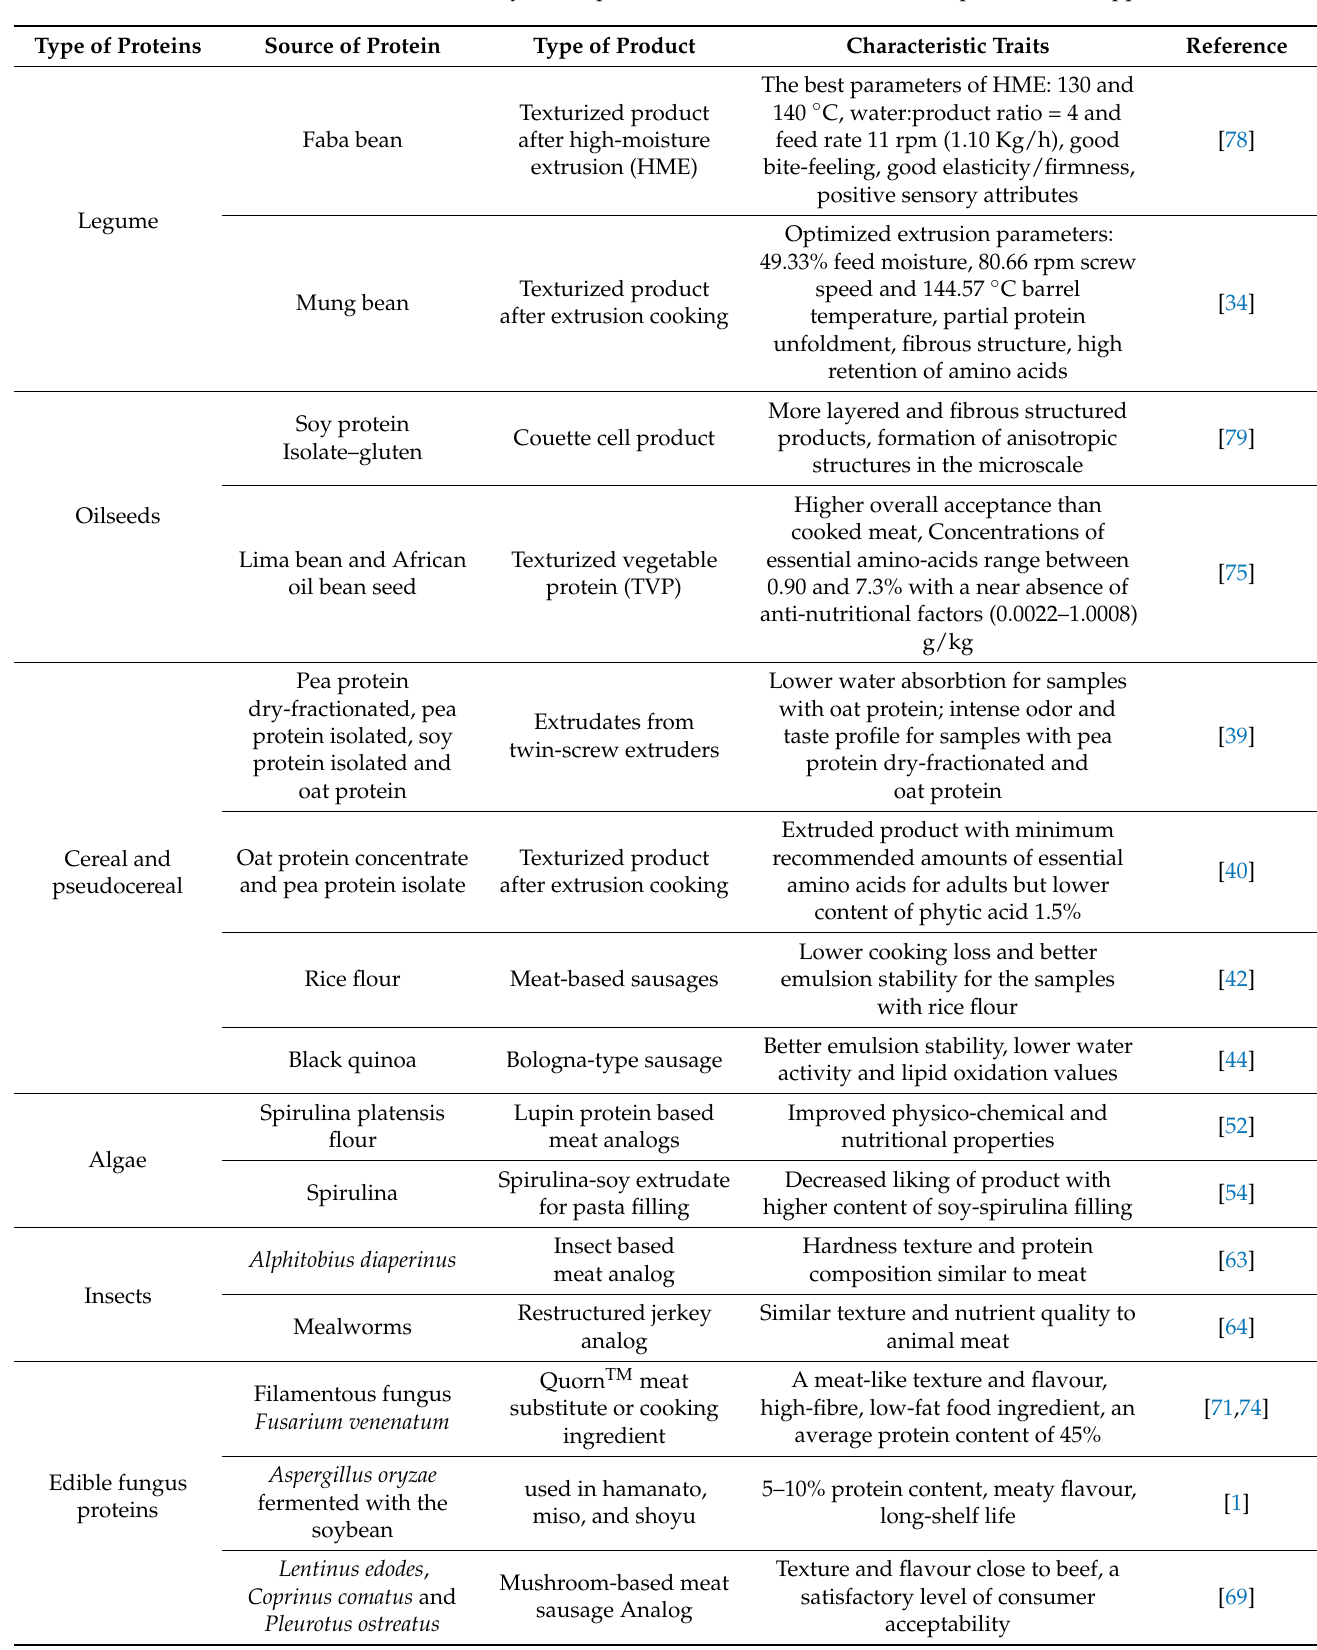
Table 1. Summary of real products where the novel sources of proteins were